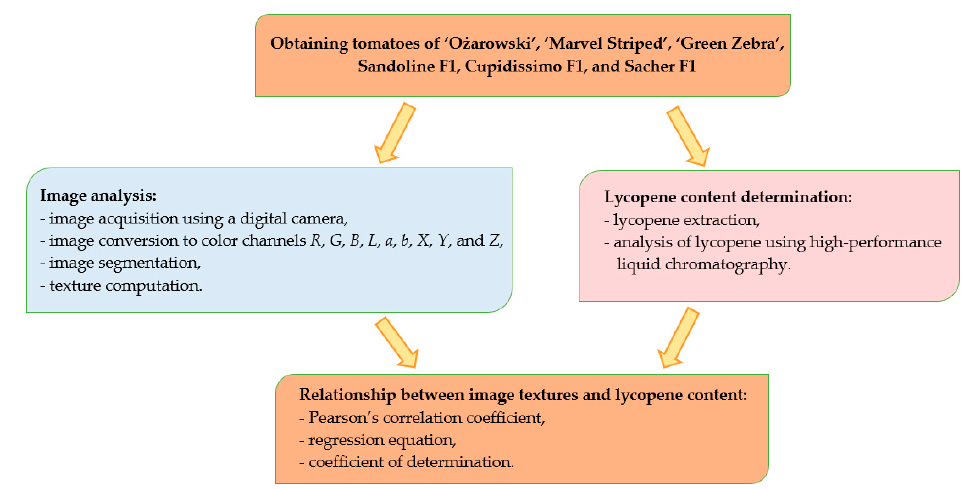
Figure 3. The flowchart presenting the stages for determining the relationship between image textures of tomato fruit and lycopene content .